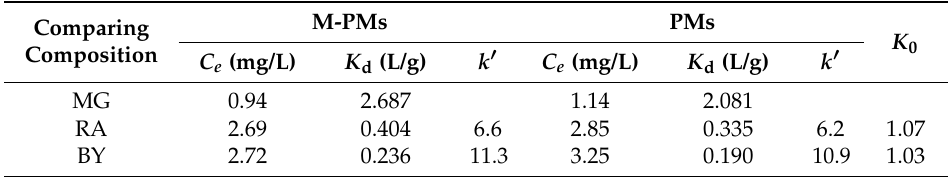
Table 5. Partition and selectivity coefficients for PMs and